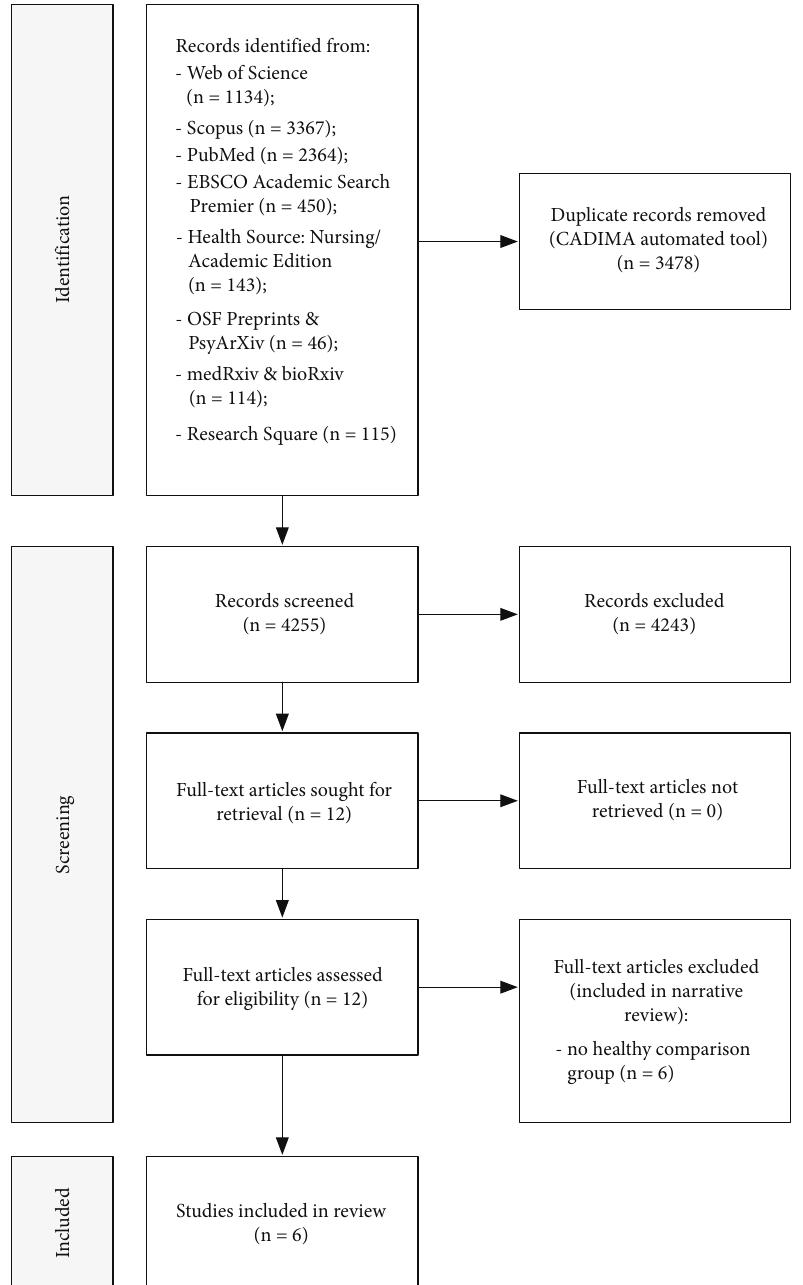
Figure 1: PRISMA fl owchart for study identi fi cation and